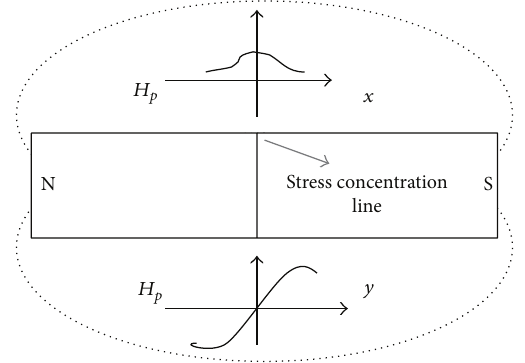
Figure 1: Principle diagram of MMM testing.